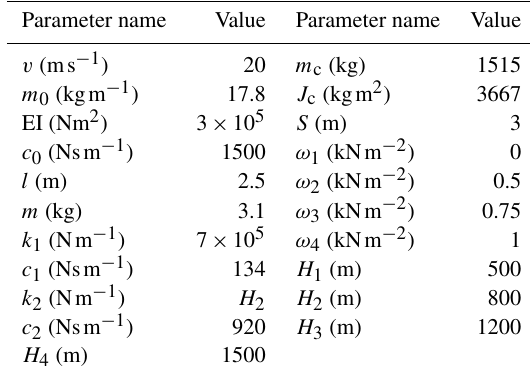
Table 1. Main input parameters for the